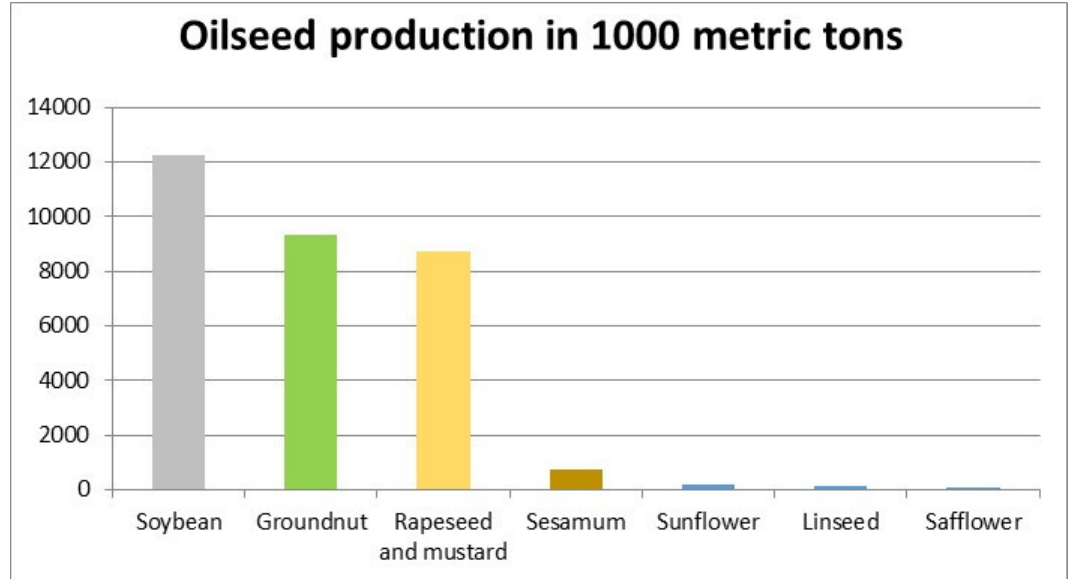
Figure 1. Production scenario of different oilseeds in India in 2020 (adapted from Statista Research Department, https://fr.statista.com/a-propos/notre-engagement-pour-la-recherche (accessed on 2